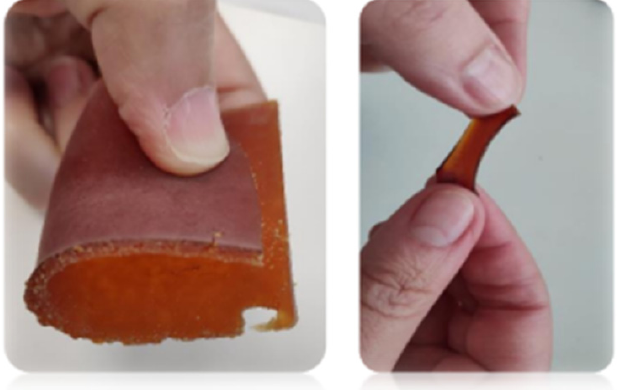
Figure 3. Picture of the flexible polyester obtained using the FDR.